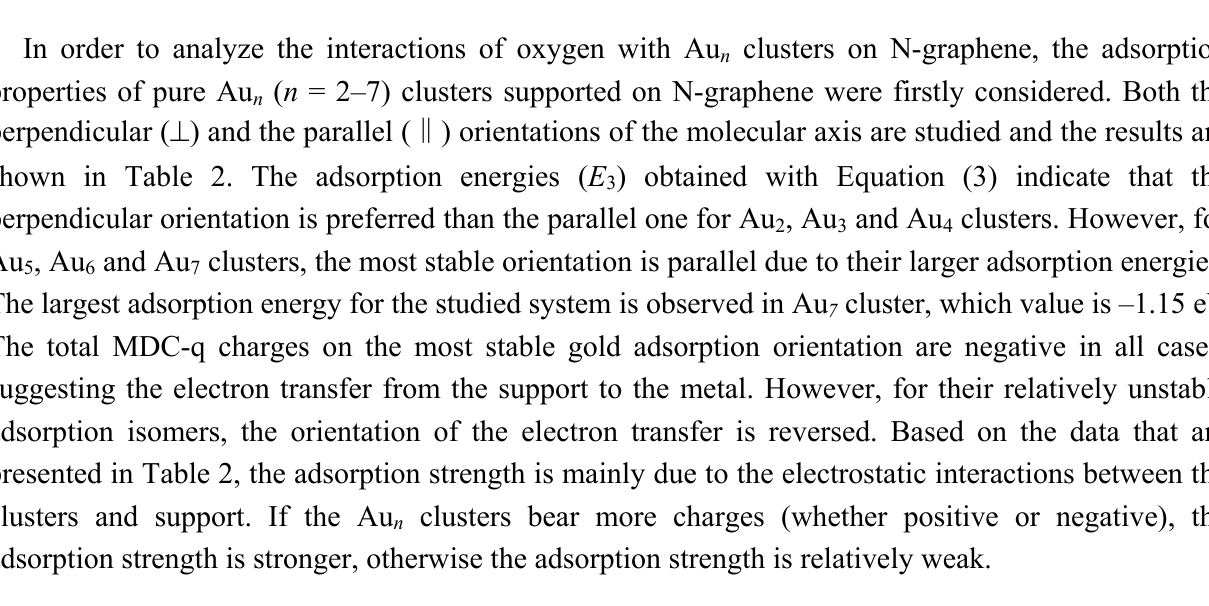
Table 2. Adsorption properties of the studied Au